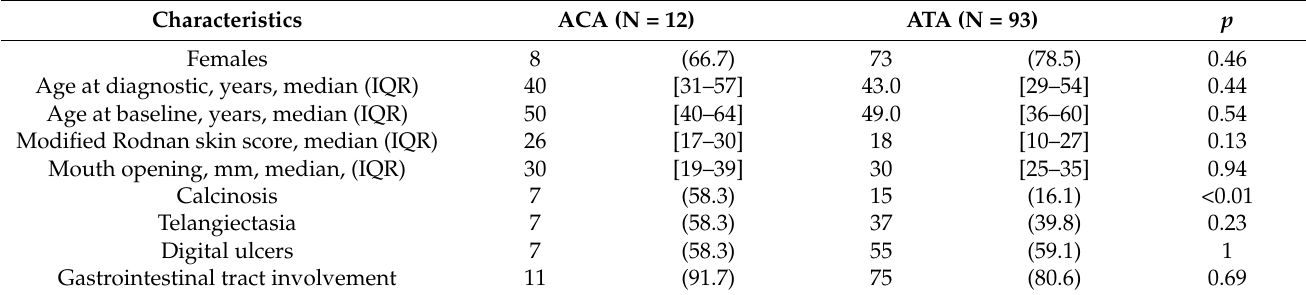
Table 2. Demographic characteristics of patients with diffuse systemic sclerosis